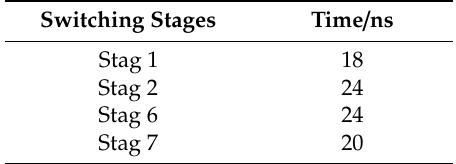
Table 4. Time of Stage 1, Stage 2, Stage 3, Stage 4 with traditional driver.